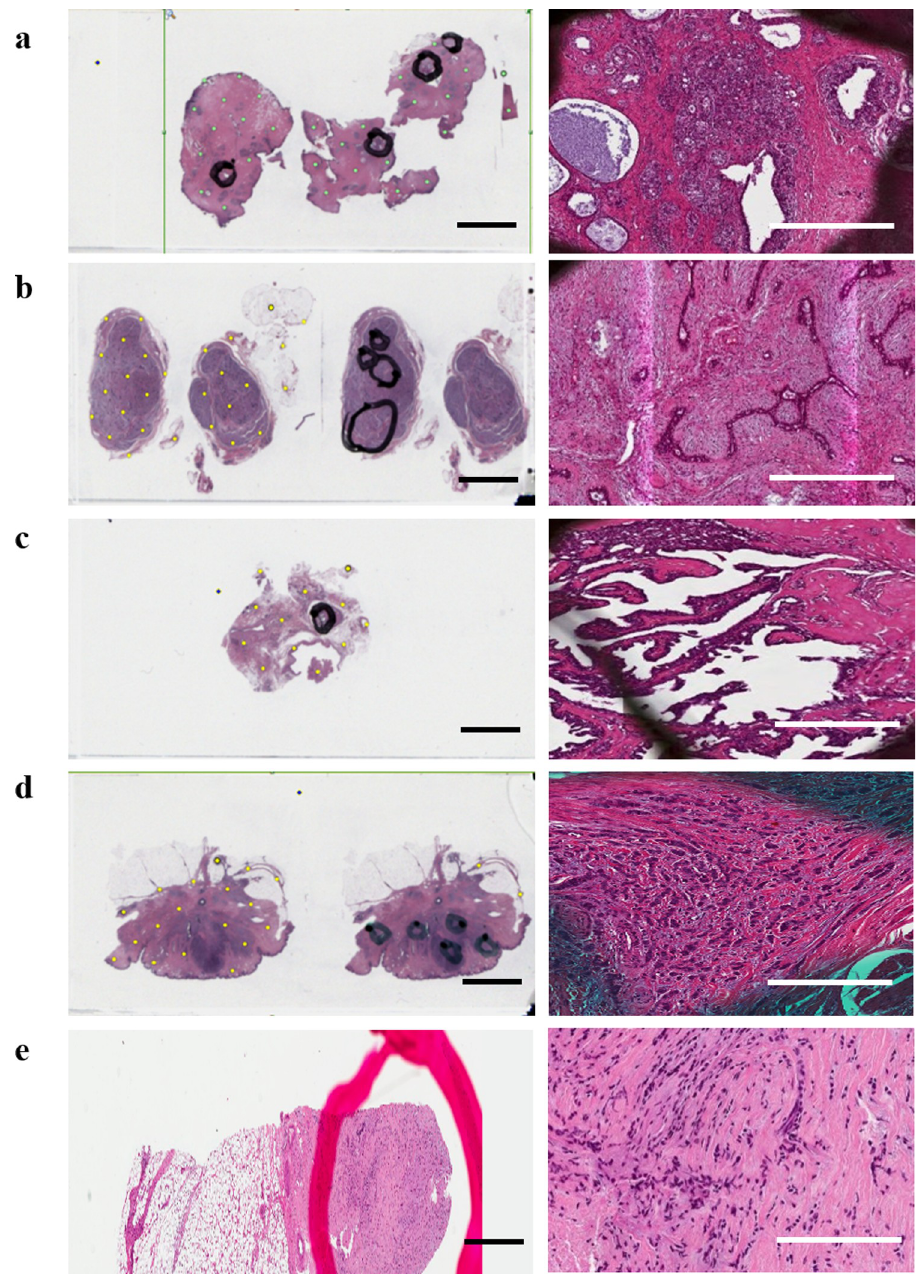
Fig 1. Digital pathology scan of H & E stained tissue section (left) and magnified image of one of the regions of interest marked by the pathologist (right) for (a) fibrocystic lesion, (b) fibroadenoma, (c) intraductal papilloma, (d) infiltrative ductal carcinoma, (e) infiltrative lobular carcinoma. H&E (scale bar 2.5 cm) & Magnified images (scale bar 0.1mm). obtained from 12 PC scores, resulting in sensitivity and specificity of < 71% and < 80% respec- tively. For RBF c-svc SVM, the optimal result was obtained from 15 PC scores with 90% sensi- tivity and < 92% specificity while for RBF nu-svc SVM, the optimal result was obtained from 15 PC scores with ~90% sensitivity and ~93% specificity.